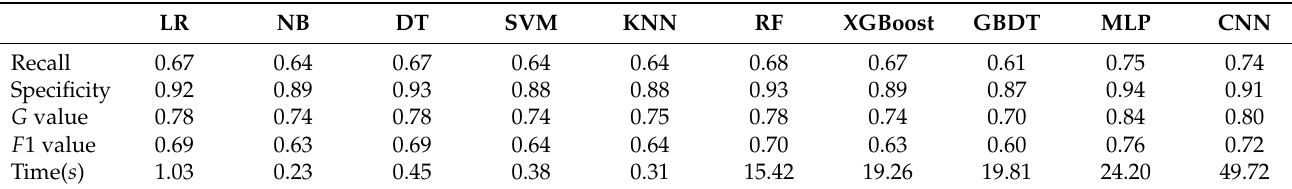
Table 10. Evaluation measures of each machine learning model in the multi-class balanced SVD dataset. LR